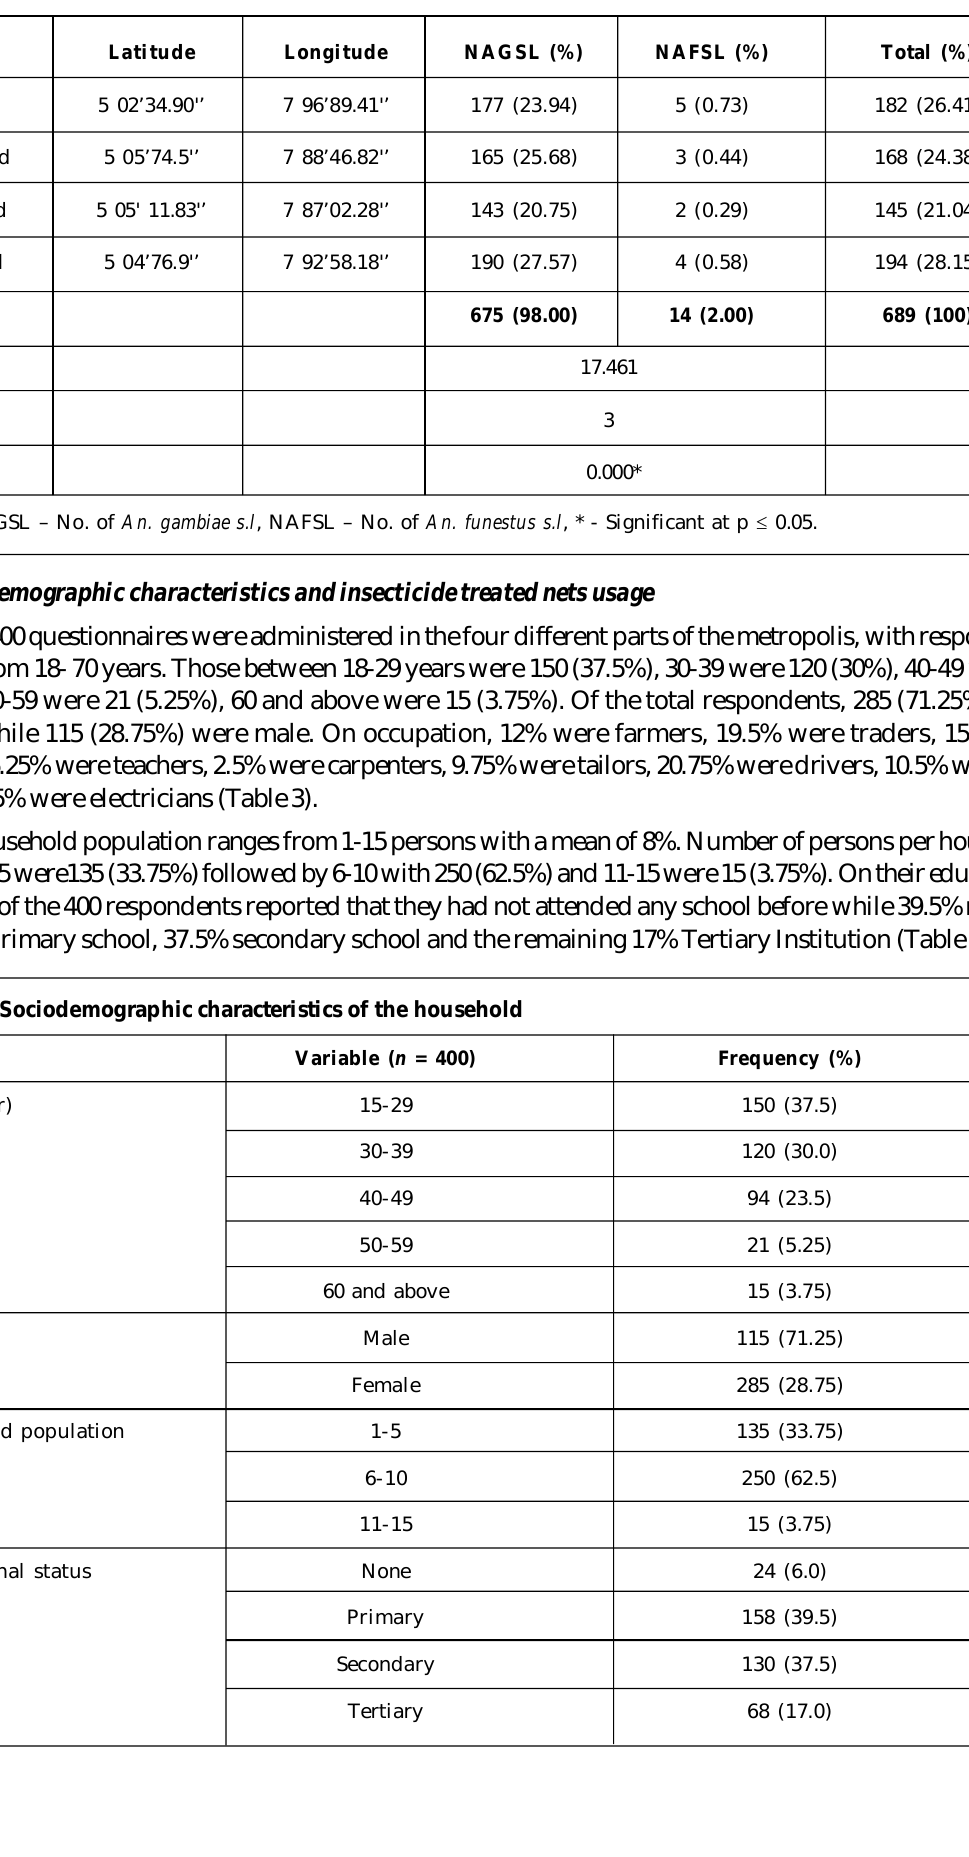
Table 2: Abundance and distribution of female Anopheles mosquito within the areas in Uyo,